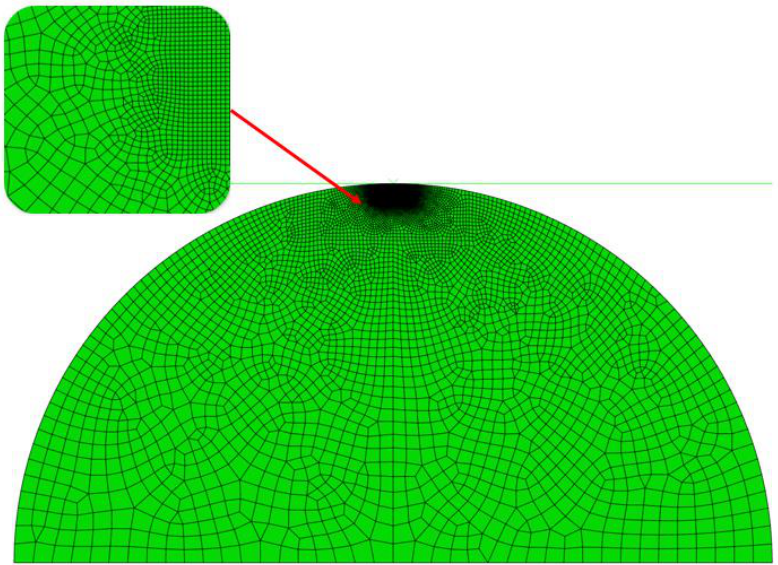
Figure 10. Schematic of finite element modeling of a spherical asperity.